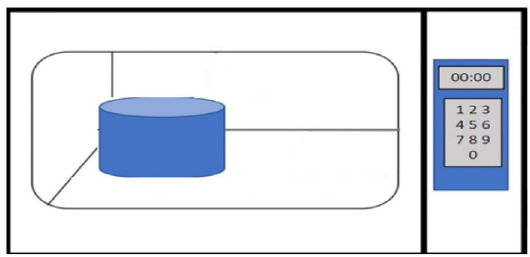
Figure 2. Microwave emitter reactor with sample location.